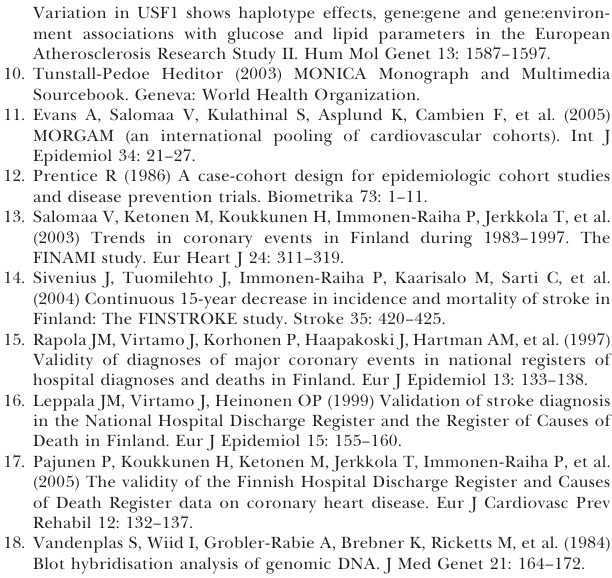
Table S1. Association between USF1 SNP Alleles and Lipids, BMI, and Waist-To-Hip Ratio in FINRISK Subcohort Males and Females Found at DOI: 10.1371/journal.pgen.0020069.st001 (27 KB